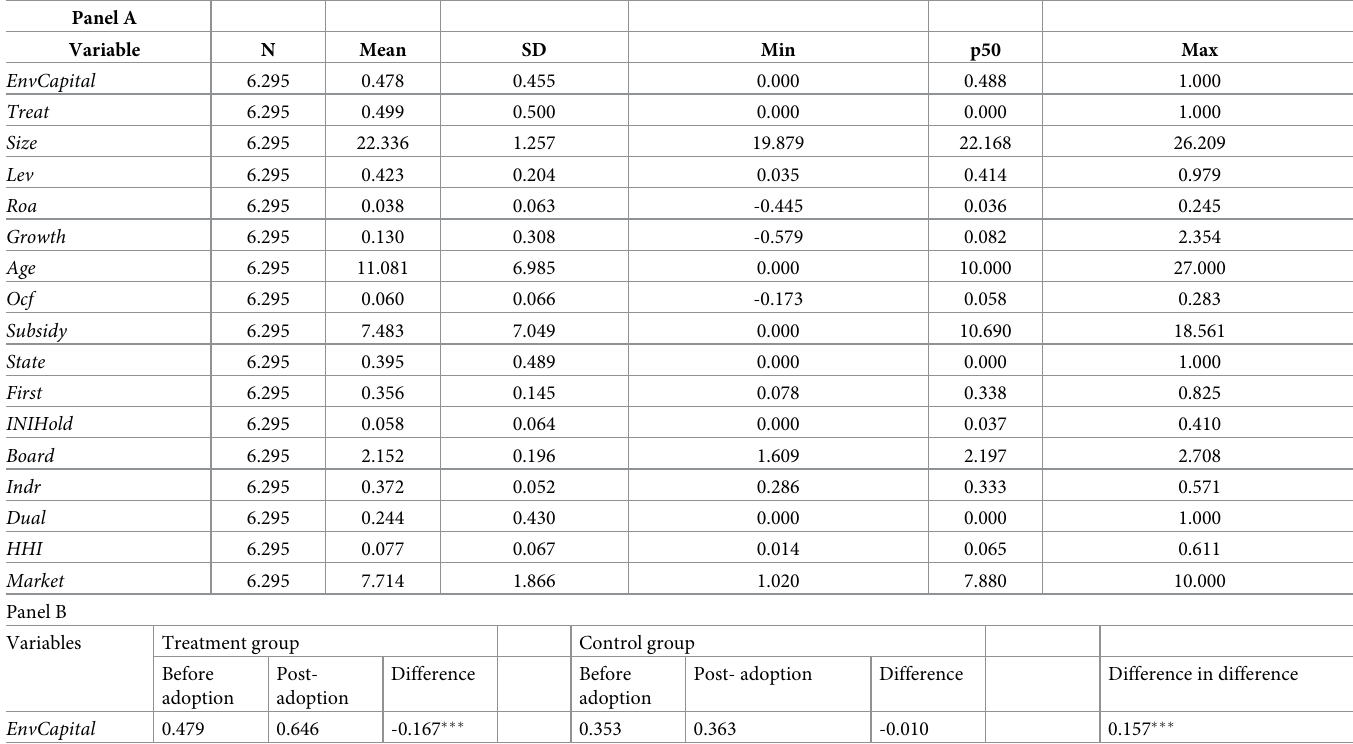
Table 2. Descriptive